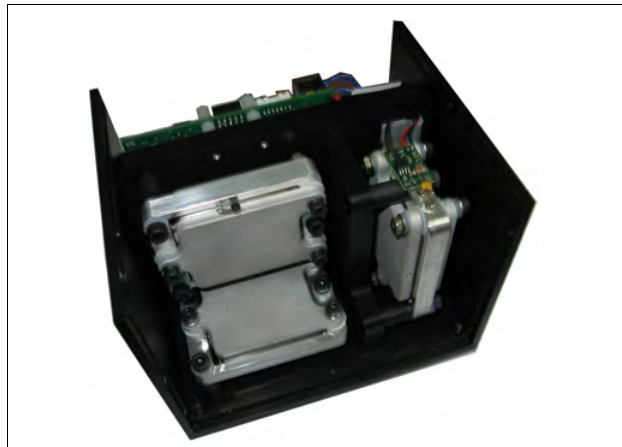
FIGURE 4 | Picture of a three-axis accelerometer by AGI srl. The three gray elements are transducers for measuring the x, y, and z components of the acceleration. Typically, the accelerometer is closed to protect the transducers and the acquisition